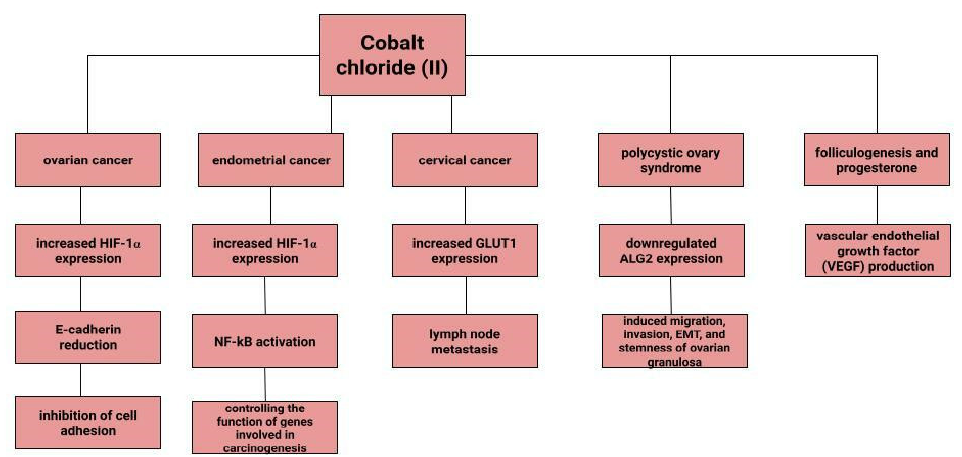
Figure 3. The role of cobalt chloride (II) in gynecological diseases.